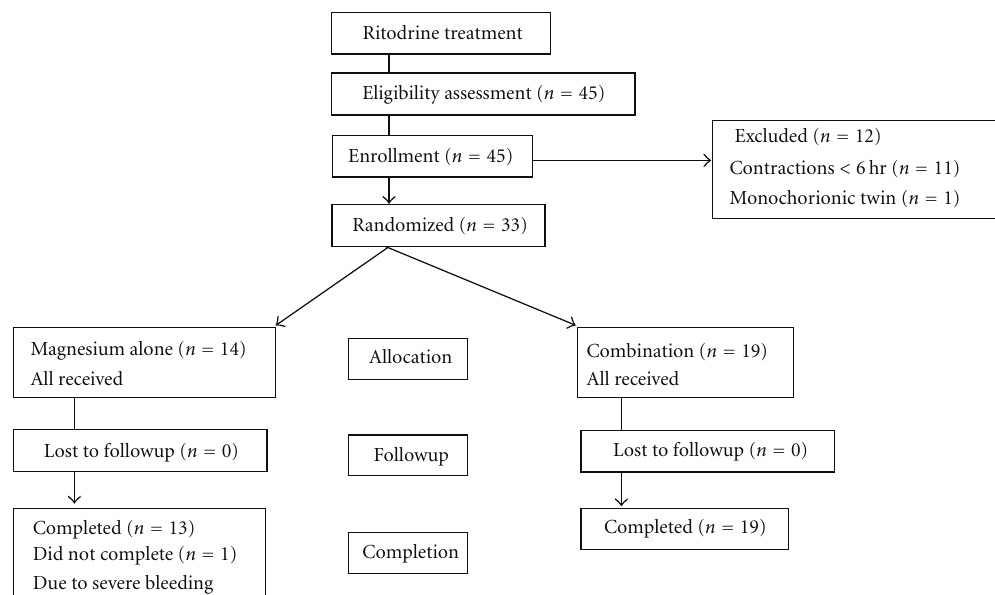
Figure 1: Flowchart of a simple 2-arm randomized controlled